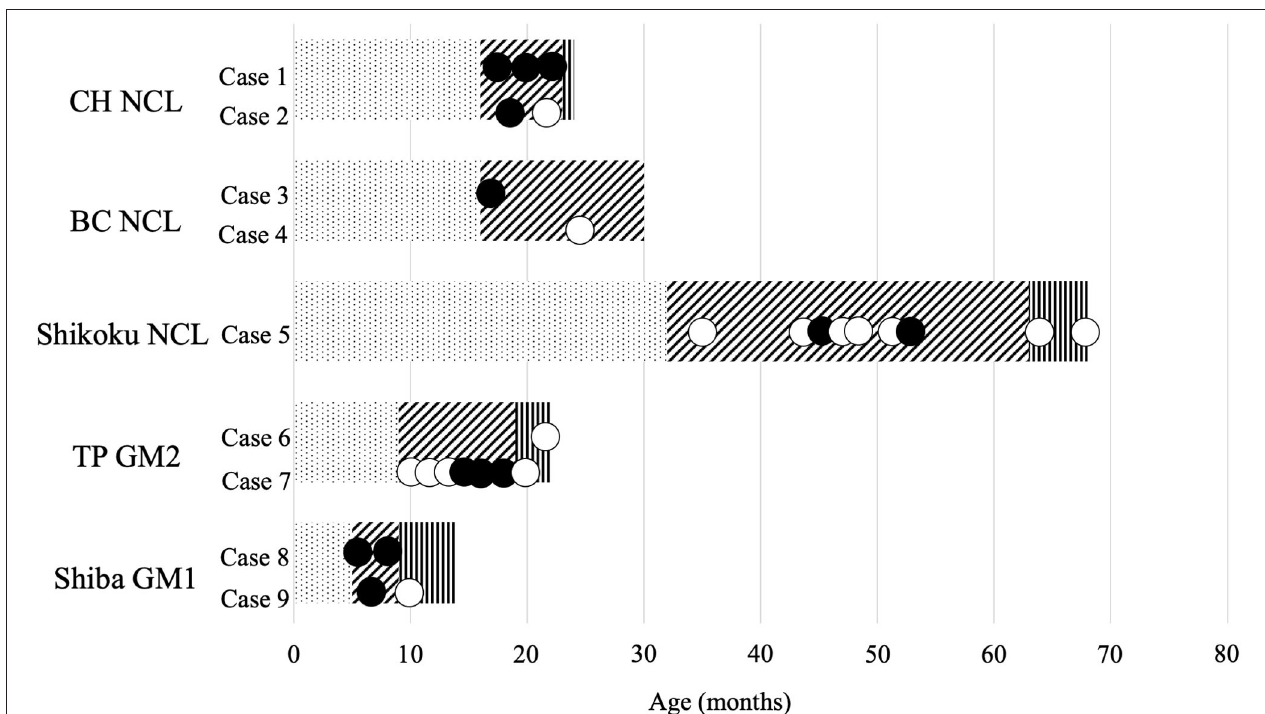
FIGURE 1 | Available videos of canine lysosomal storage diseases. CH, Chihuahua; BC, Border Collie; TP, Toy Poodle; NCL, neuronal ceroid lipofuscinosis; GM2, GM2 gangliosidosis; GM1, GM1 gangliosidosis. The bar graph indicates the approximate stages of disease: dot, before onset; diagonal line, with clinical signs; vertical line, in a lateral recumbent position. Black circle, videos with positioning head tilt observed; white circle, videos without positioning head tilt